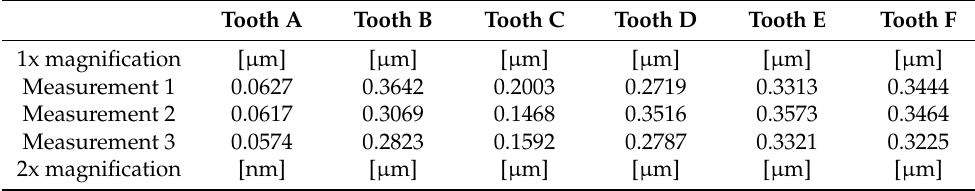
Table 2. Profilometer